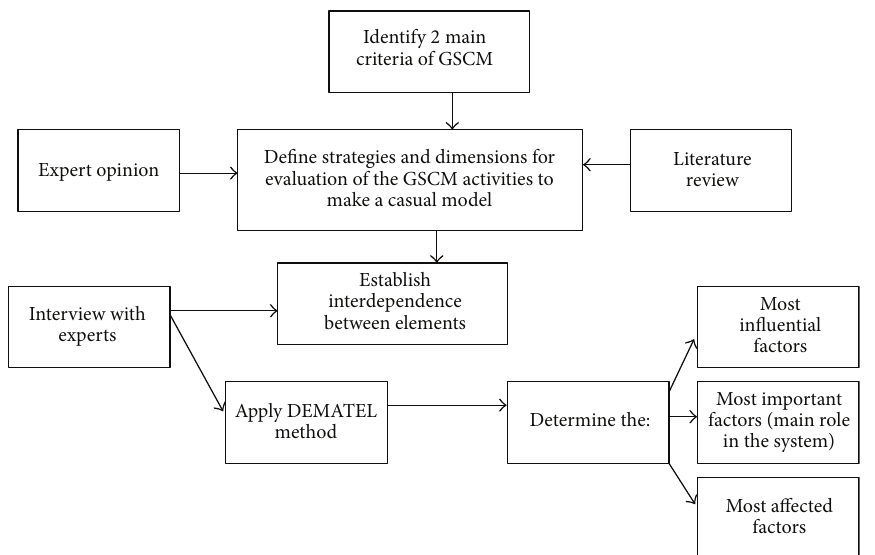
Figure 1: Causal evaluation model